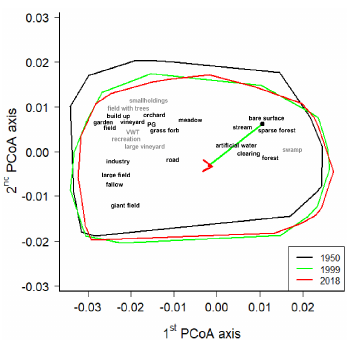
Figure A1. The principal coordinates analysis (PCoA) of land-cover data (proportions were square- rooted and the Bray–Curtis dissimilarity and Hellinger distance used) of all 115 grid cells in the Podyjí/Thayatal NPs detected in the years 1950, 1999 and 2018. Envelopes were drawn around the marginal grid cells in the PCoA diagram. The coloured arrow shows the shift of land-cover medoids between the searched years (1950, 1999 and 2018). Individual land covers are projected as weighted averages; grey coloured land covers occurred in less than 30 grid cells; VWT—vineyards with trees, PG—public greenery.